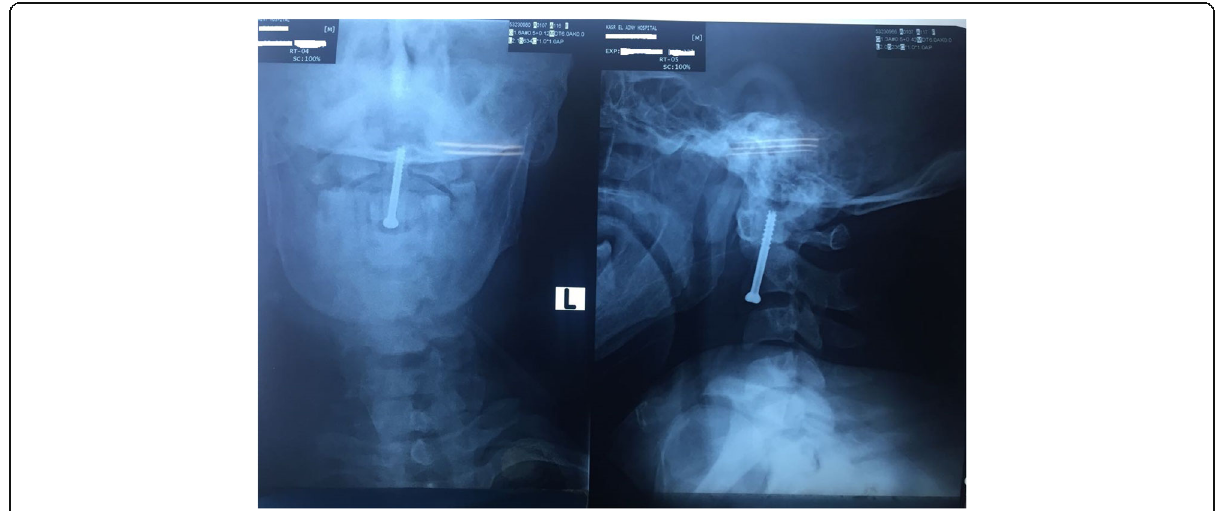
Fig. 3 Postoperative images showing the final position of the screw. The screw is impacted into the inferior endplate of C2 body (owing to its short head) with its anterior edge covering the head of the screw